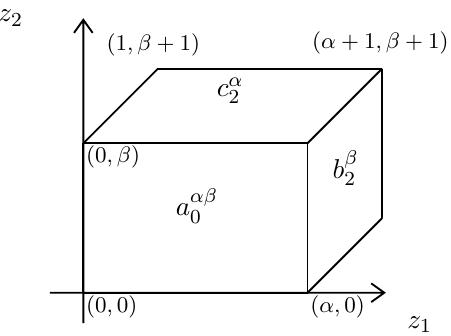
, c (cid:11) and b (cid:12) , producing the extreme 2 0 2